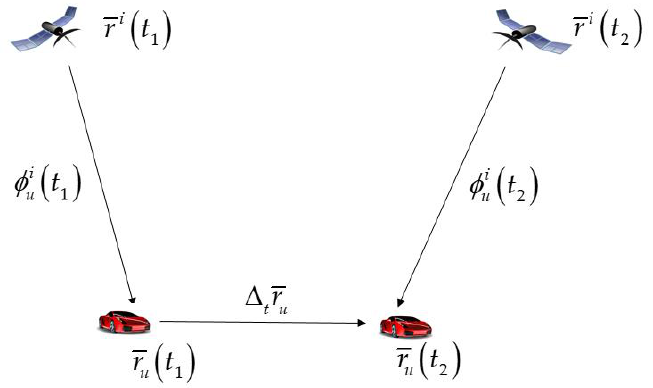
Figure 3. Consecutive carrier phase measurements at time epochs t 1 and t 2